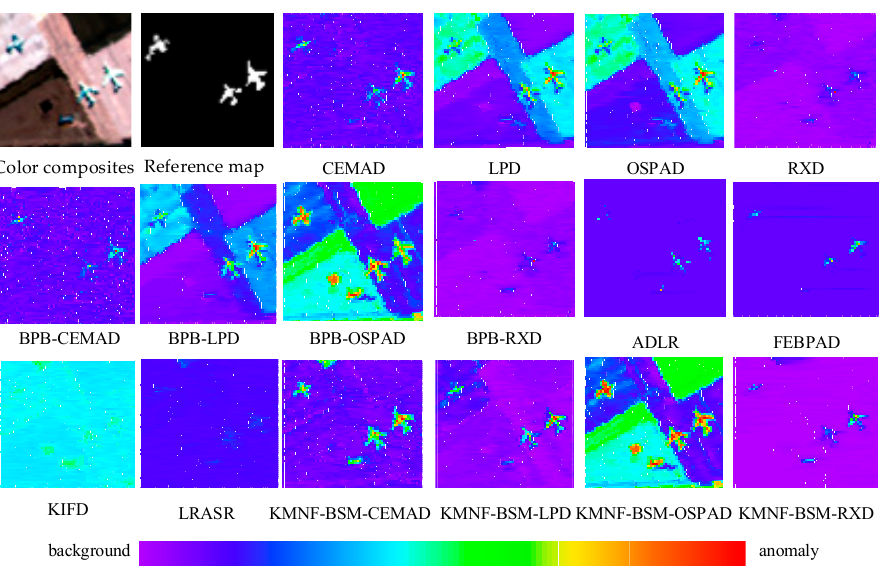
Figure 4. The detection maps of different detectors for the airport scene. The visual detection results of different methods for the beach scene are depicted in Figure 5. Similar to the results of the airport scene, LPD, OSPAD, BPB-LPD, BPB-OSPAD, BPB-RXD, KIFD, KMNF-BSM-LPD, and KMNF-BSM-OSPAD demonstrate poor back- ground suppression, generating high FARs. Compared with CEMAD, RXD, BPB-CEMAD, ADLR, FEBPAD, LRASR, and KMNF-BSM-RXD, the KMNF-BSM-CEMAD successfully suppresses the background and effectively detects the anomalies. The results suggest that the KMNF-BSM-RXD outperforms BPB-RXD and is relatively similar to RXD.